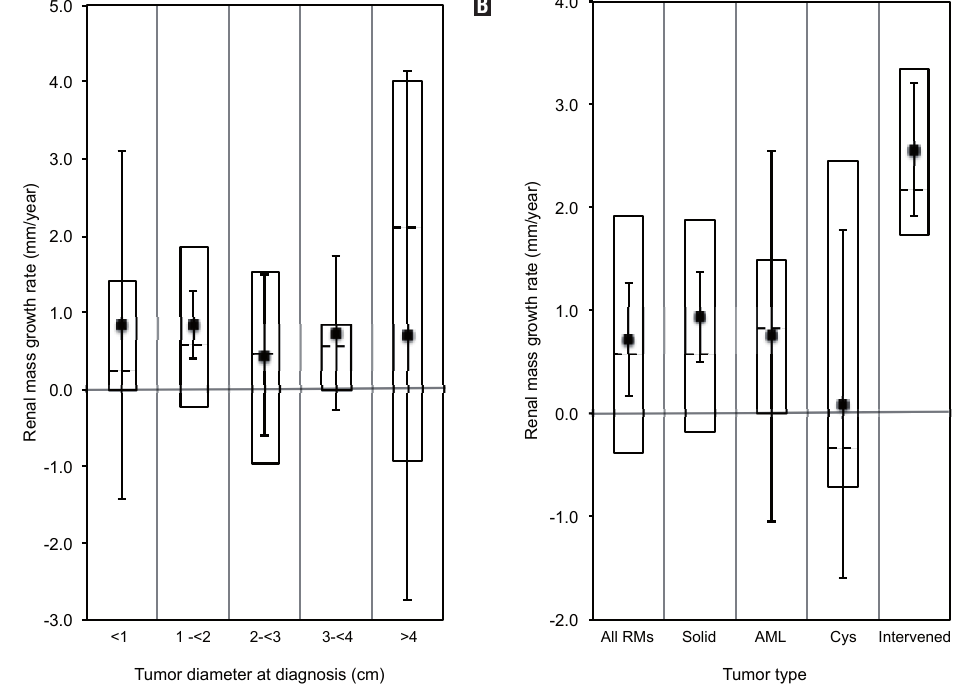
figure 3 - Renal mass growth rates (mm/year) stratified according to A: maximal tumor diameter at diagnosis and B: tumor type (data shown as mean±95% CI, median, 1 st and 3 rd